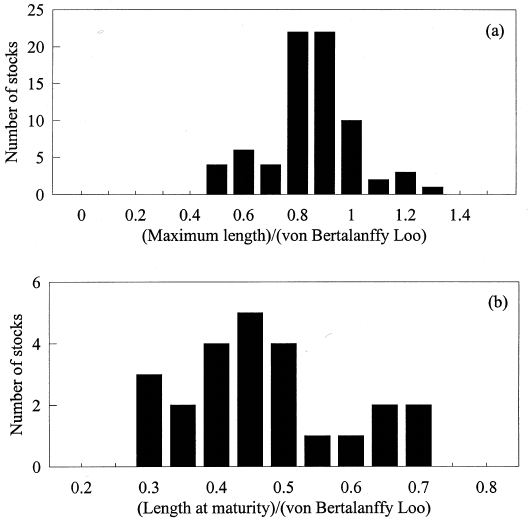
Fig. 5. The ratios of (a) maximum length over the von Bertalanffy L and (b) length-at-maturity over L oo stocks in Hellenic waters.